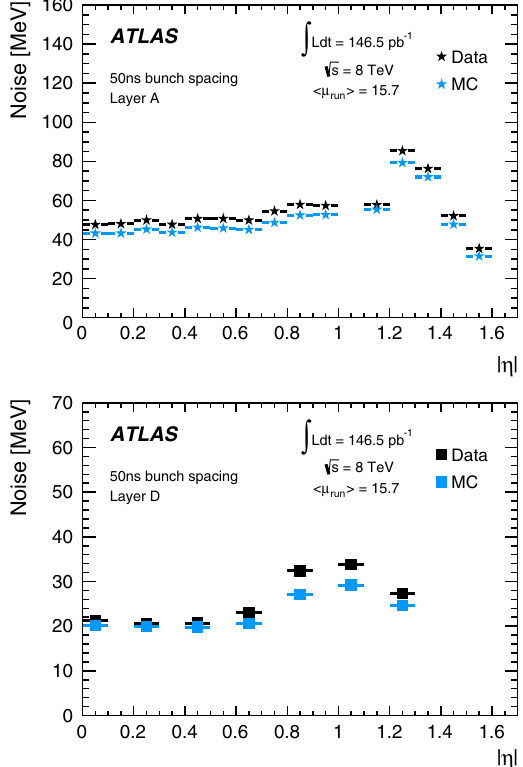
Fig. 11 The total noise per cell as a function of | η | for (cid:4) μ run (cid:5) = 15 . 7, for the high–high gain combination. The data from a 2012 run, with a bunch spacing of 50ns, are shown in black while the simulation is